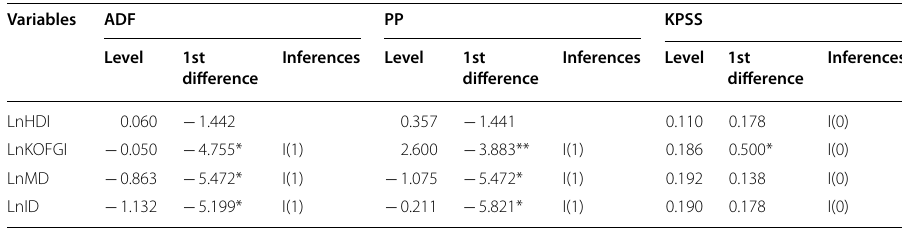
Table 4 Unit root test